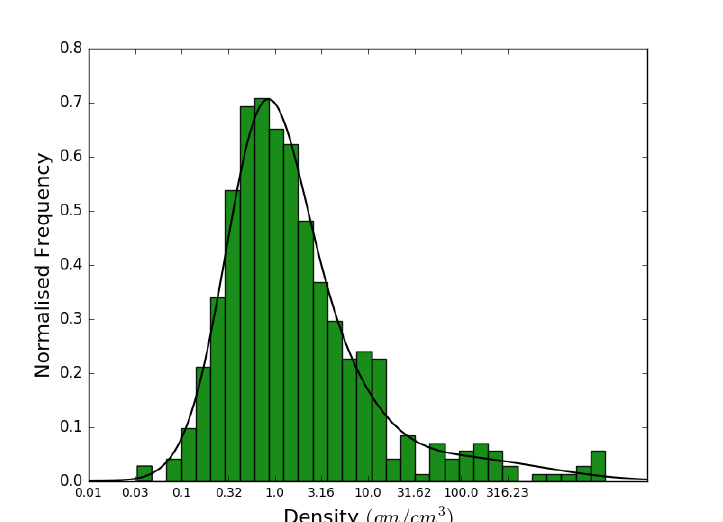
Figure 3. The GMM based fit for the density of the exoplanets using the best-fit parameters from Eq. 6 for k = 3. Details of the fit can be found in Table 1.